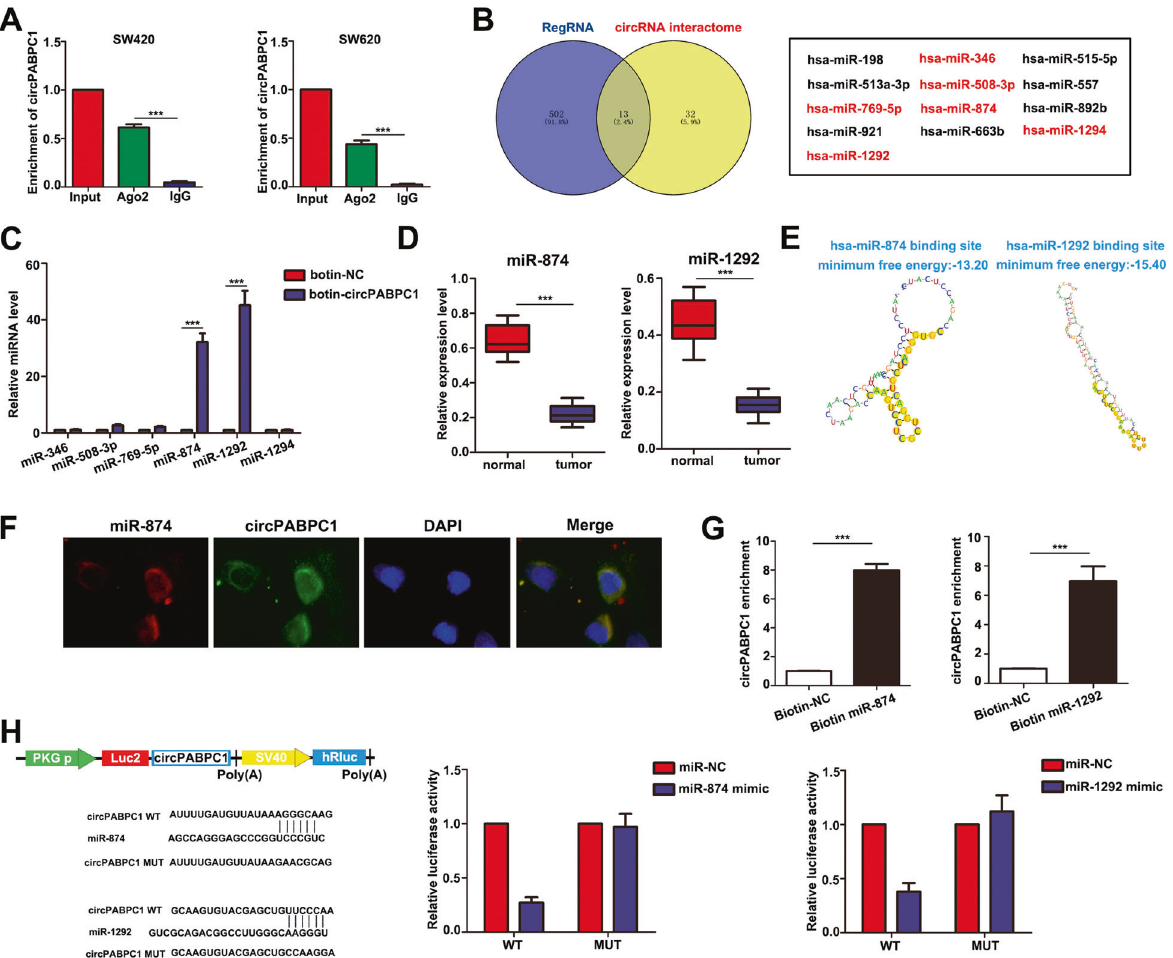
RegRNA and circRNA interactome databases. C CircPABPC1-speci fi c probes were used to perform RNA RIP experiments. D The expression of miR-874 and miR-1292 was detected in CRC and adjacent normal tissues. E The secondary structure of potential miR-874-/miR-1292- binding sites in circPABPC1 was predicted by RegRNA. F The colocalization of miR-874 and circPABPC1 was con fi rmed by FISH assays. G A biotinylated RNA pull-down assay was performed to detect the miR-874- or miR-1292-captured circPABPC1 fractions. H Luciferase reporter activity was measured in CRC cells after cotransfection with circPABPC1-WT or circPABPC1-Mut and miR-874/miR-1292 mimic. Scale bar = 50 μ m. Quantitative data from three independent experiments are shown as the mean ± SD (error bars). * P < 0.05, ** P < 0.01, *** P < 0.001 (Student ’ s t